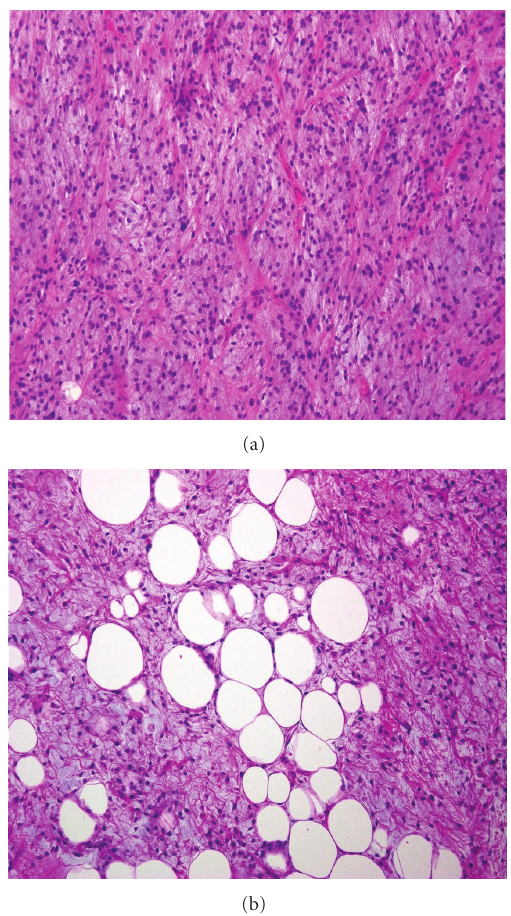
Figure 4: Histopathological findings of the tumor diagnosed ded- i ff erentiated liposarcoma (HE stain, original magnification x200). (a) Most of the tumor cells consisted of spindle cells with high- grade atypia. (b) Some of which were identified to be lipoblasts in a myxoid